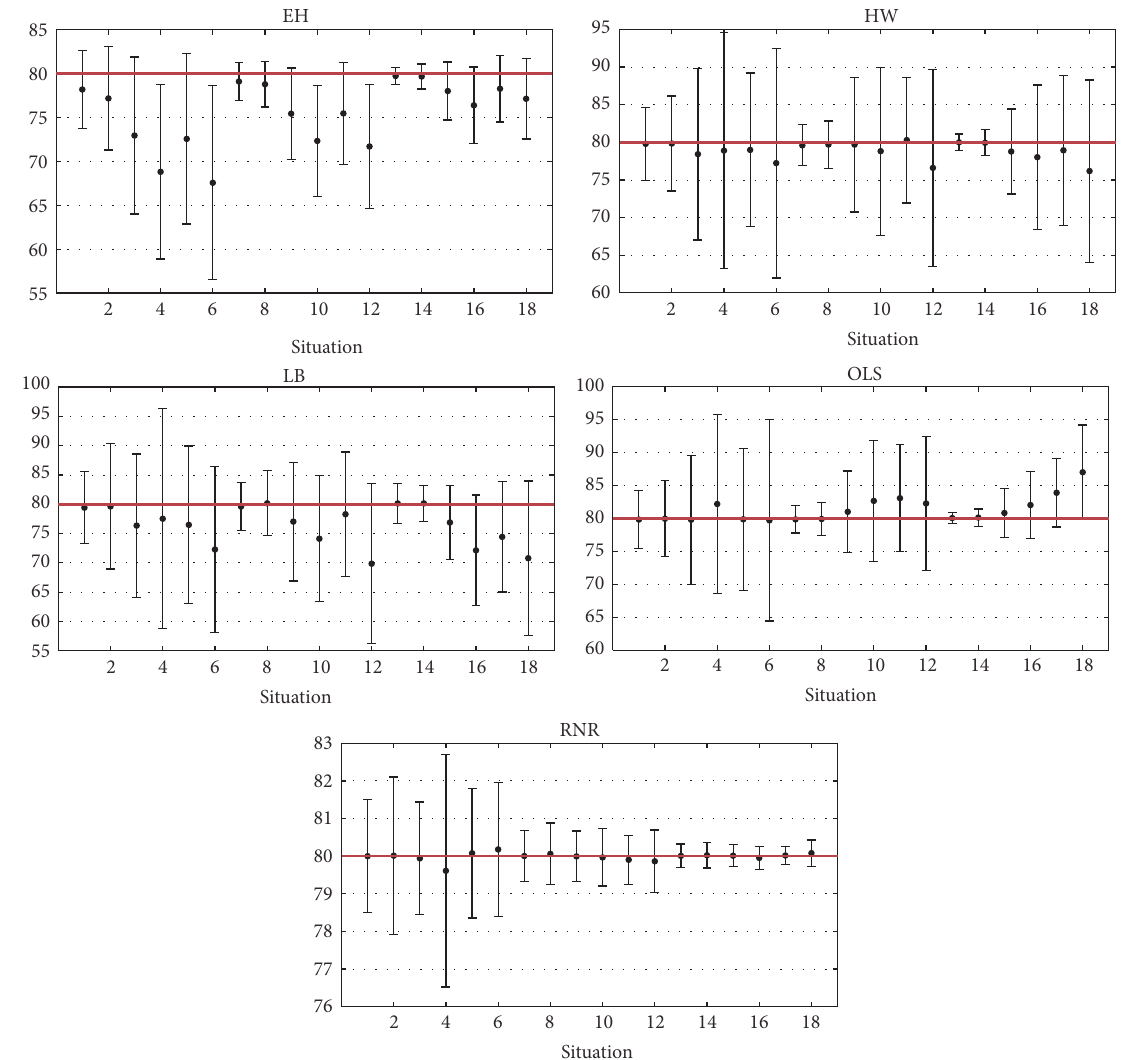
Figure 4: Mean estimated values (black dots) and standard deviations of maximum initial velocity, 𝑉 max for different simulated scenarios. Red lines denote true parameter value.